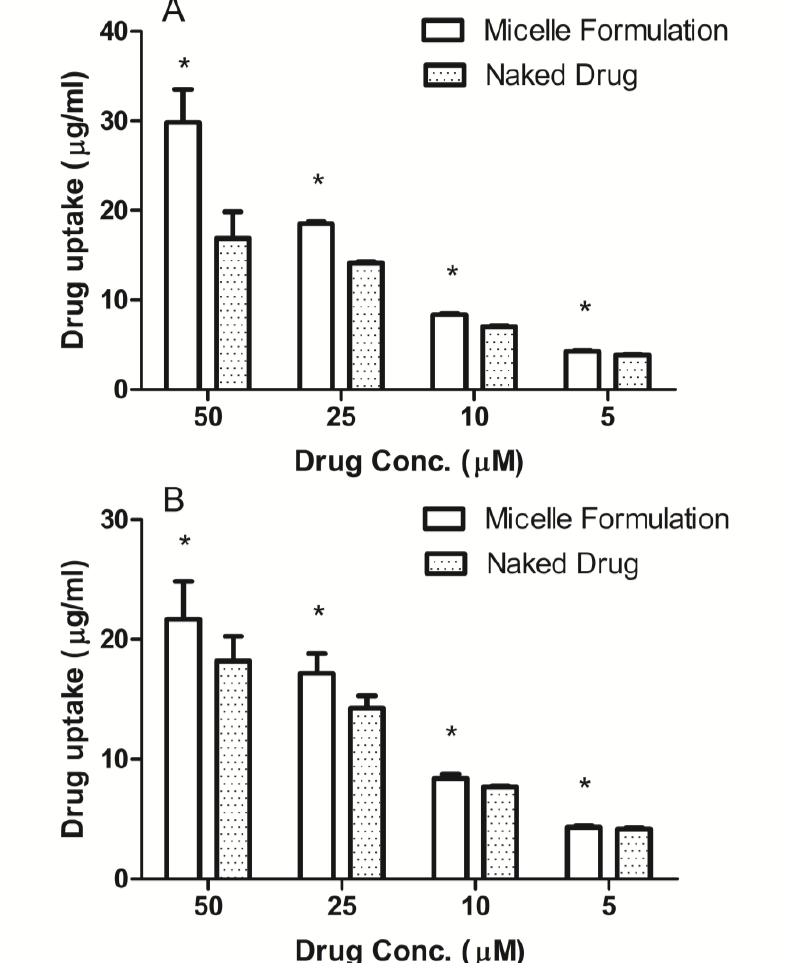
Figure 4. The micelle formulation improved ridaforolimus uptake by DU145 cells ( A ) and